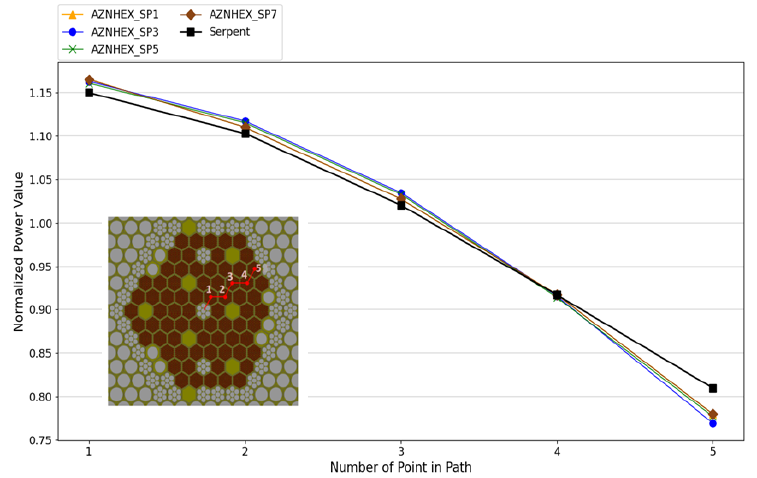
Figure 6. Normalized radial power